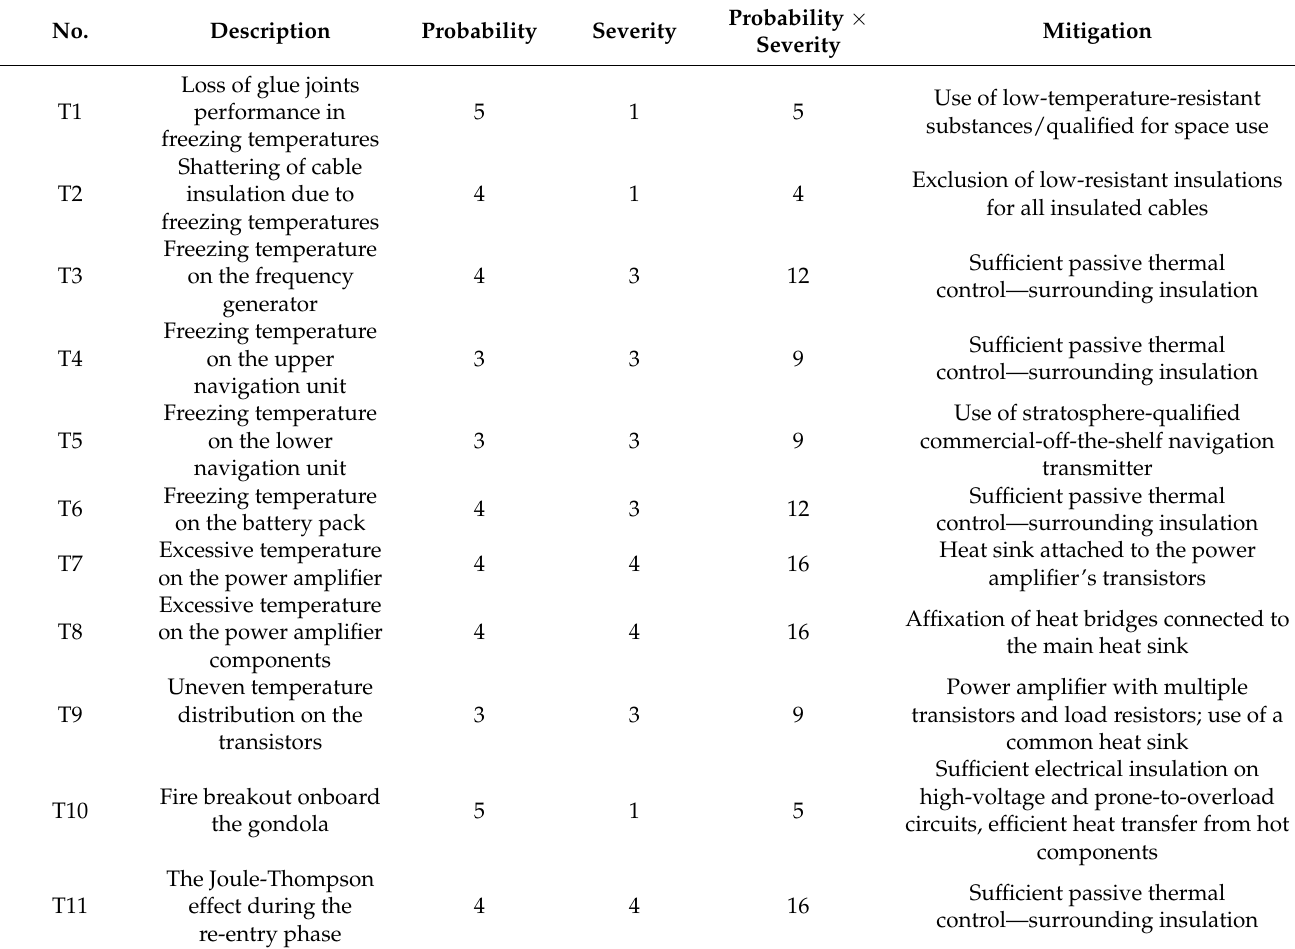
Table 3. Thermal risks for a stratospheric fully airborne VLF light balloon